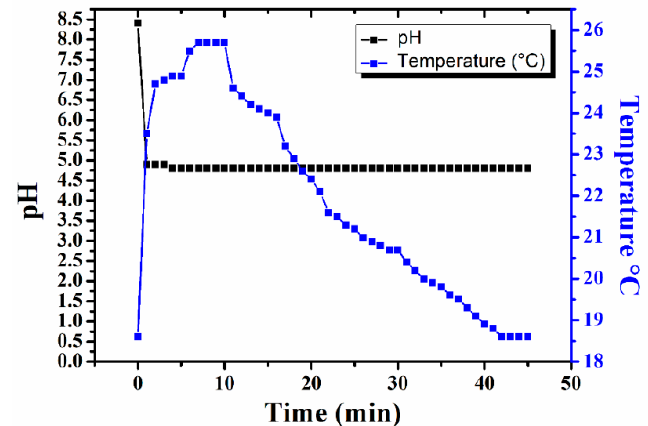
Figure 1. Change in temperature and pH against time over the course of the oxidation of aniline (50 mM) initiated by ammonium persulfate (APS; 5 mM) in 0.13 M HCl solution.